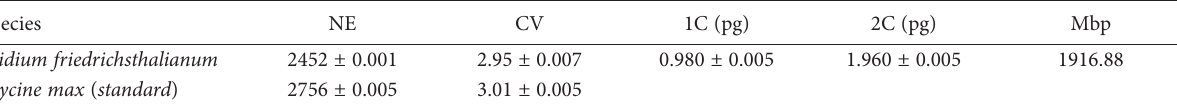
Table 3. Parameters obtained by flow cytometry to determine the genome size of Psidium friedrichsthalianum . NE : Number of events obtained; CV : Coefficient of variation obtained; 2C (pg) : holoploid nuclear DNA content obtained; 1pg DNA = 978 Mbp (Dolezel et al. 2003; Bennett et al. 2000).